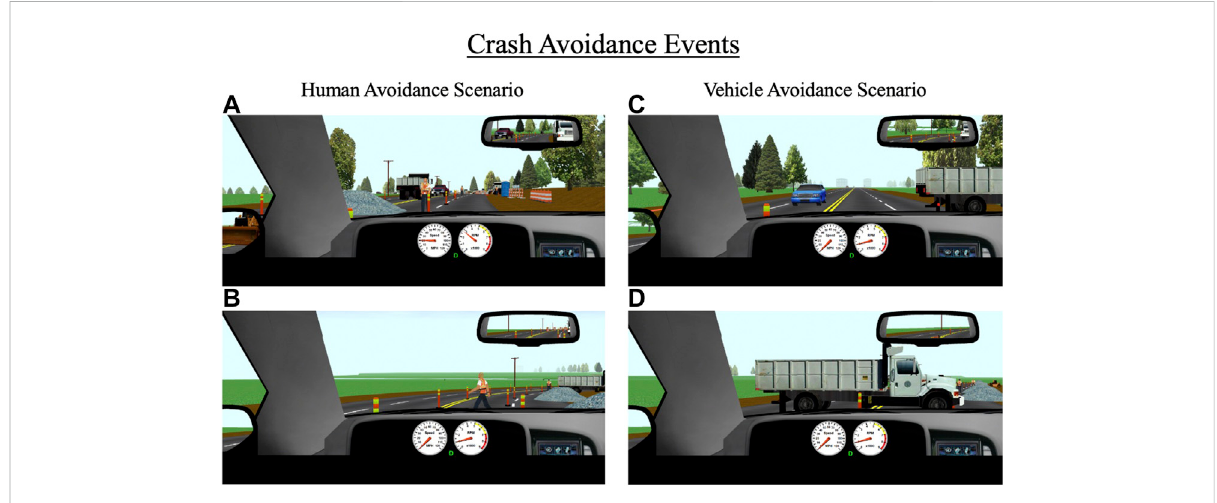
FIGURE 5 Crash avoidance events that occur throughout the drive for (A,B) human avoidance scenarios, and (C,D) vehicle avoidance scenarios. The primary outcomes for these events are collisions, reaction time to the event, and time-to-collision with the event.